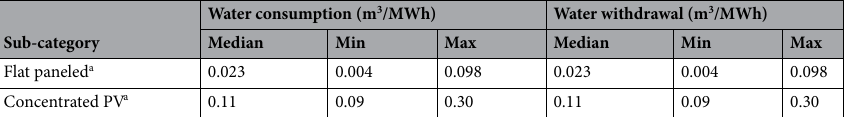
Table 14. Solar PV-generated power plant’s water withdrawal and consumption data 69 . a Reflecting data limitations and the nature of water use, we assume withdrawal and consumption are equal for all estimates in this category.